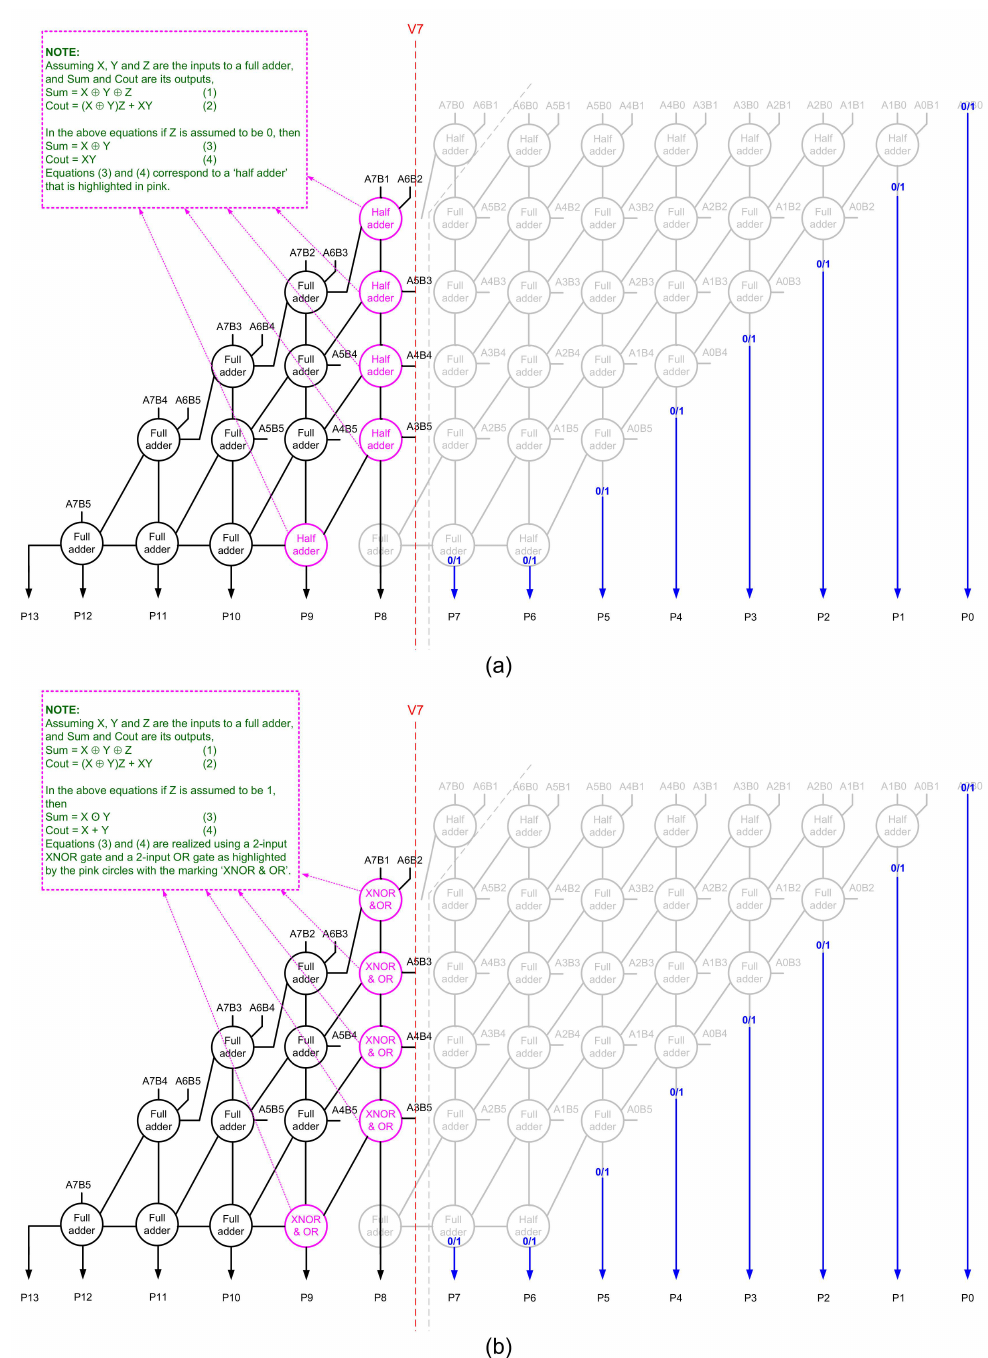
Figure 4. Logic optimization of an approximate array multiplier (obtained through vertical cut V7) based on the assignment of: ( a ) a 0 input assigned to the full adders highlighted in pink in Figure 3a; ( b ) a 1 input assigned to the full adders highlighted in pink in Figure